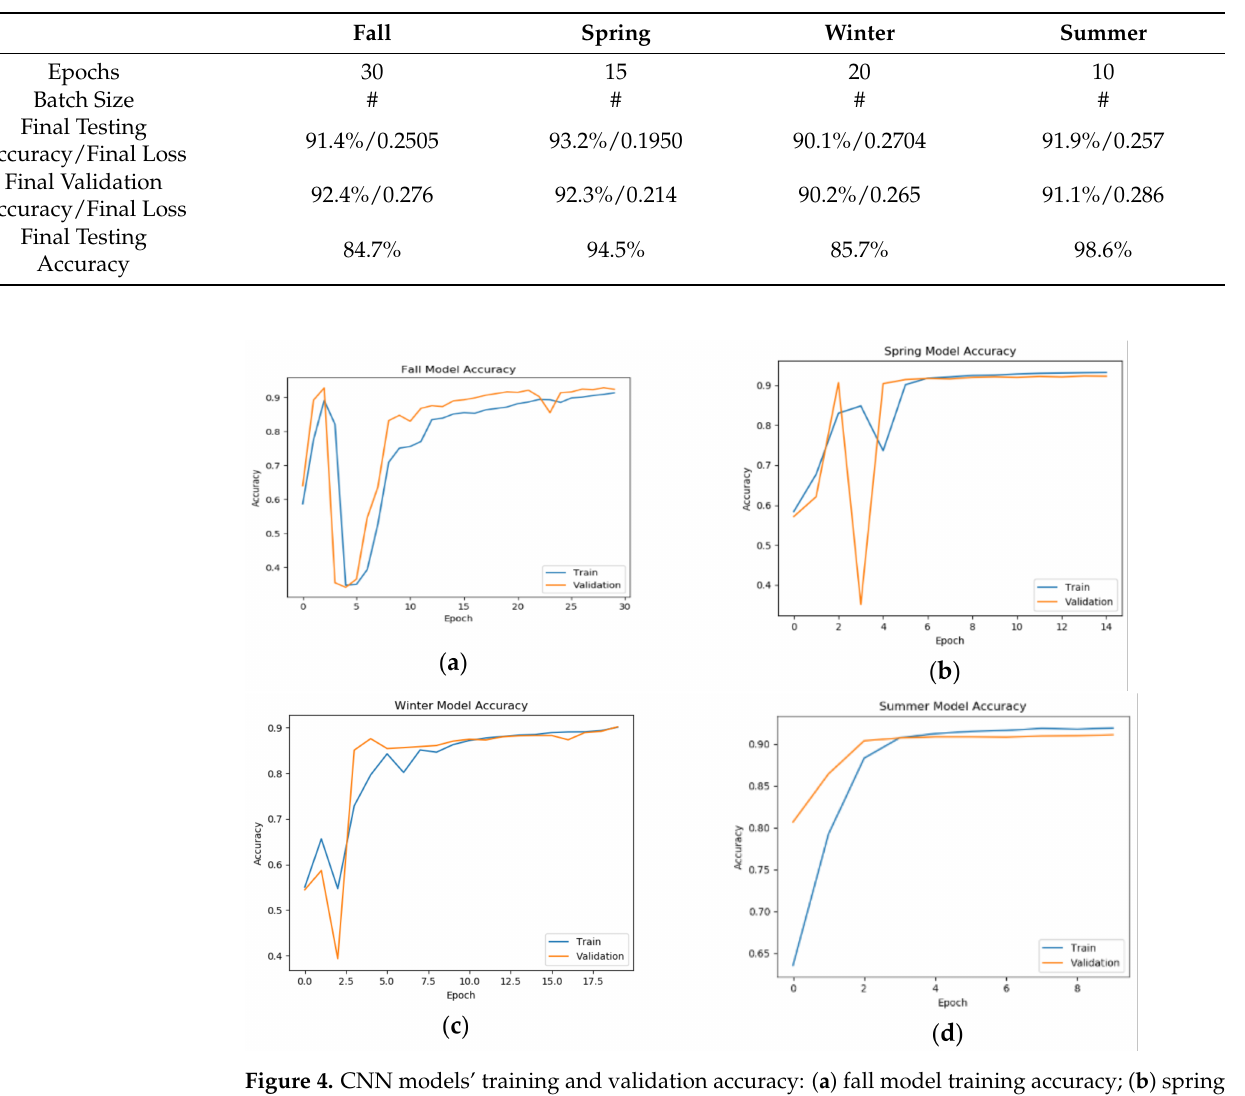
Table 1. Final CNN model results.